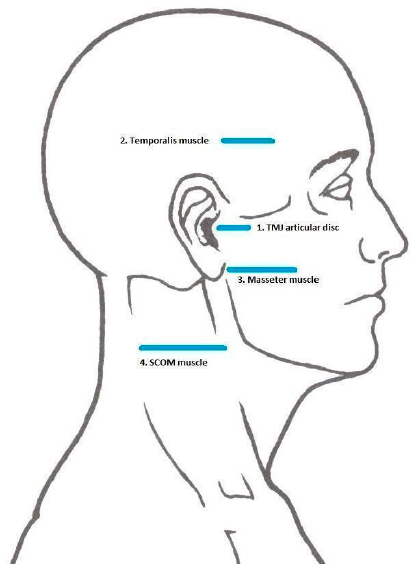
Figure 1. Reference Points for sonographic explorations.